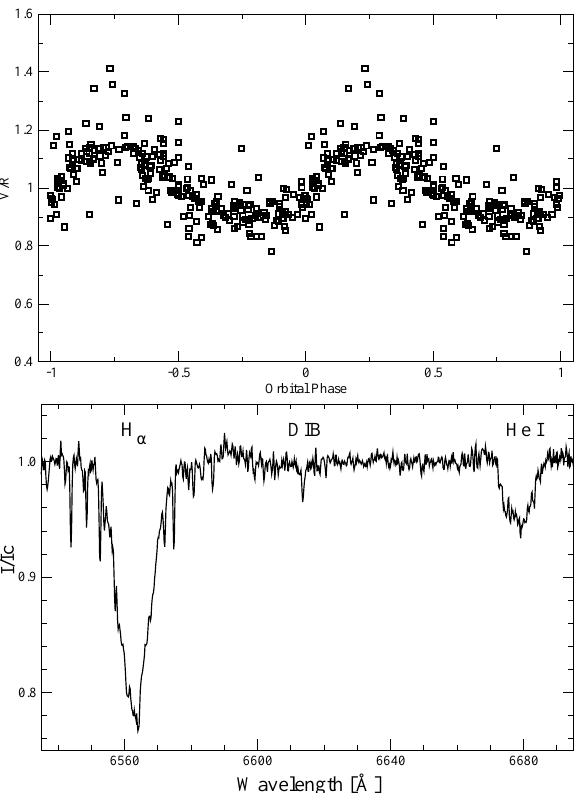
Fig. 2. Left panel: V / R variations of the double-peaked H α profile in the spectrum of π Aquarii folded with an orbital period of 84.3 days that was found from analysis of the radial velocity variations (from Zharikov et al. 2013). Right panel: The H α line profile of 66 Oph obtained at TCO in October 2016. Unmarked narrow features are telluric lines. The 6614 Ådiffuse interstellar band and the He i 6678 Åline are marked. Average signal-to-noise ratio in the contin- uum is ∼